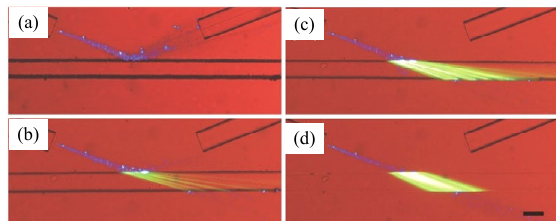
Fig. 3 Optical images of reflected and refracted light with different fluids within the detection channel: (a) air ( n =1) and (b)–(d) 0.01 mM fluorescein was introduced into the detection channel as an indicator of the refracted light. The RI of the solutions were 1.33, 1.36, and 1.42, respectively. Scale bar: 125 